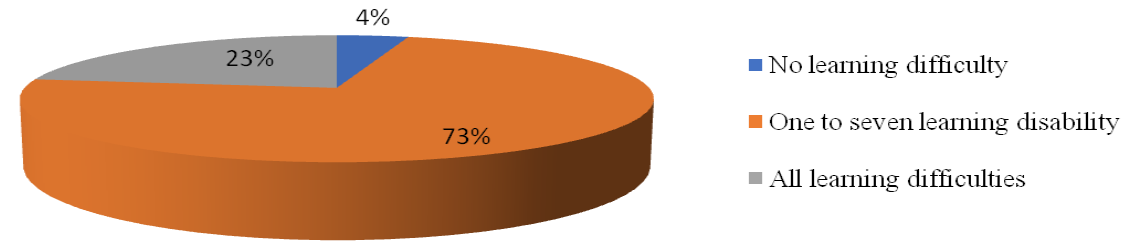
Figure 2. Distribution of a number of learning difficulties present among the participants. Table 6. Multiple binary logistic regression analysis of student diagnosed with any psychiatric disorder-related